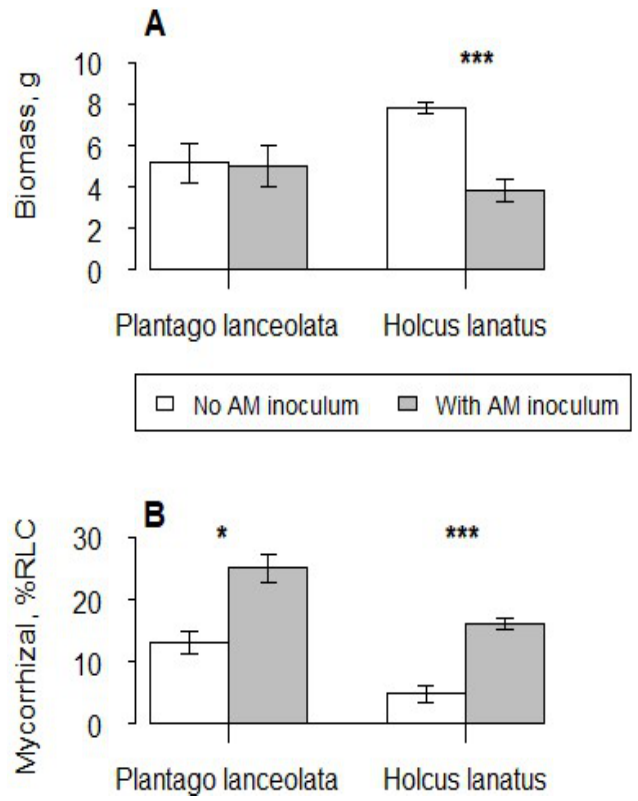
Figure 2. Mean of ( A ) dry shoot biomass and ( B ) AM fungal colonisation of the native plant species when grown in interspecific competition with I. glandulifera . Vertical bars represent ± one standard error. Asterisks above bars indicate significance of difference between means, *: p < 0.05; ***: p < 0.001.